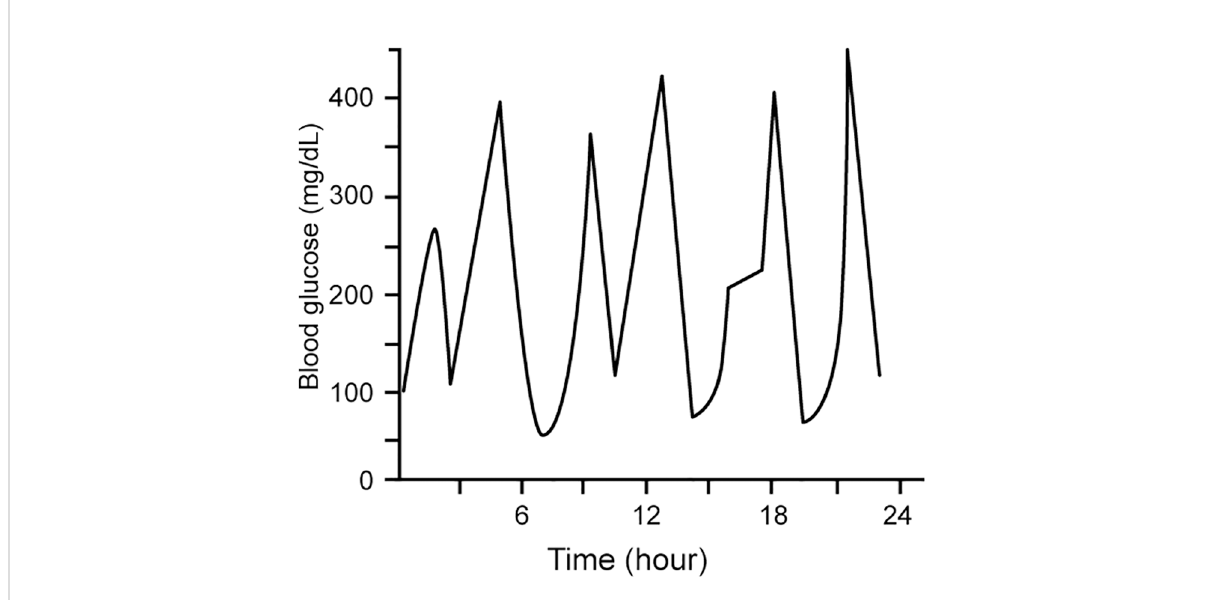
FIGURE 3 Short-term glycemic variability, represented by within-day measures of blood glucose as determined by SBGM and CGM. Modi fi ed with permission from